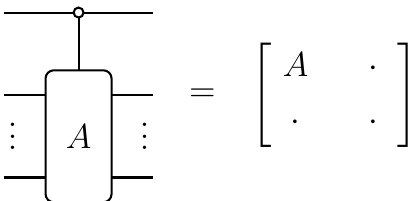
FIG. 4. A simple block-encoding quantum circuit, showing how such a block encoding of a unitary A is notated. Observe that the empty circle on the control qubit (top line) indicates a | 0 (cid:6) control, whereas a filled-in circle would correspond to a | 1 (cid:6)